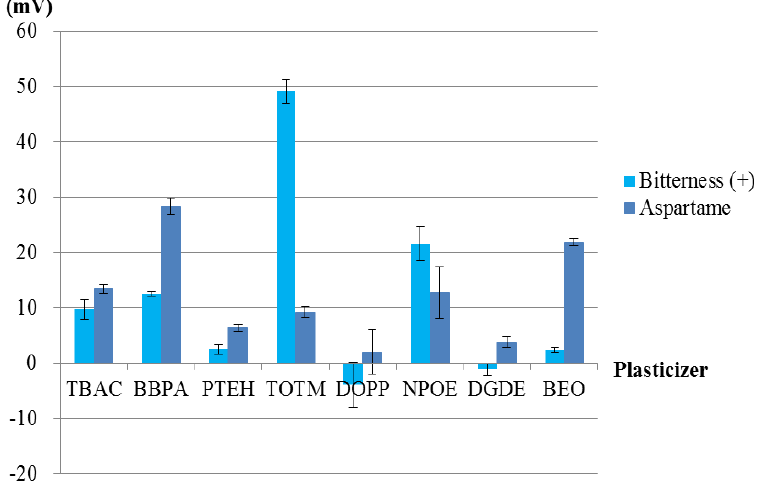
Figure 9. The selectivity of the membranes comprising PAEE, PVC and one of the eight types of plasticizer in terms of CPA values. Bitterness (+) and aspartame samples were measured using eight kinds of lipid/polymer membrane (parameter: type of